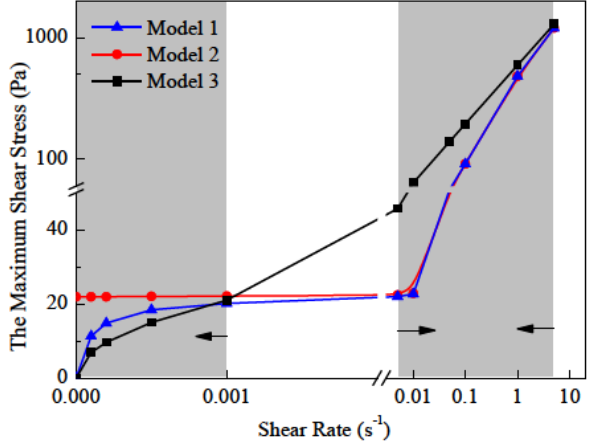
Figure 18: The relationship between the maximum shear stress and shear rate obtained from different rheological models